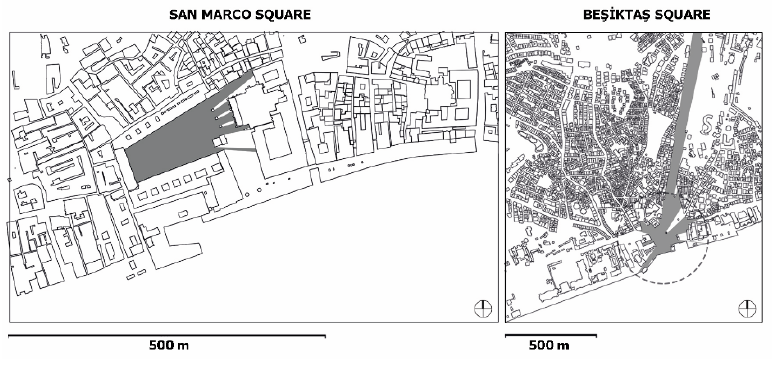
Figure 6. Isovist polygon of squares